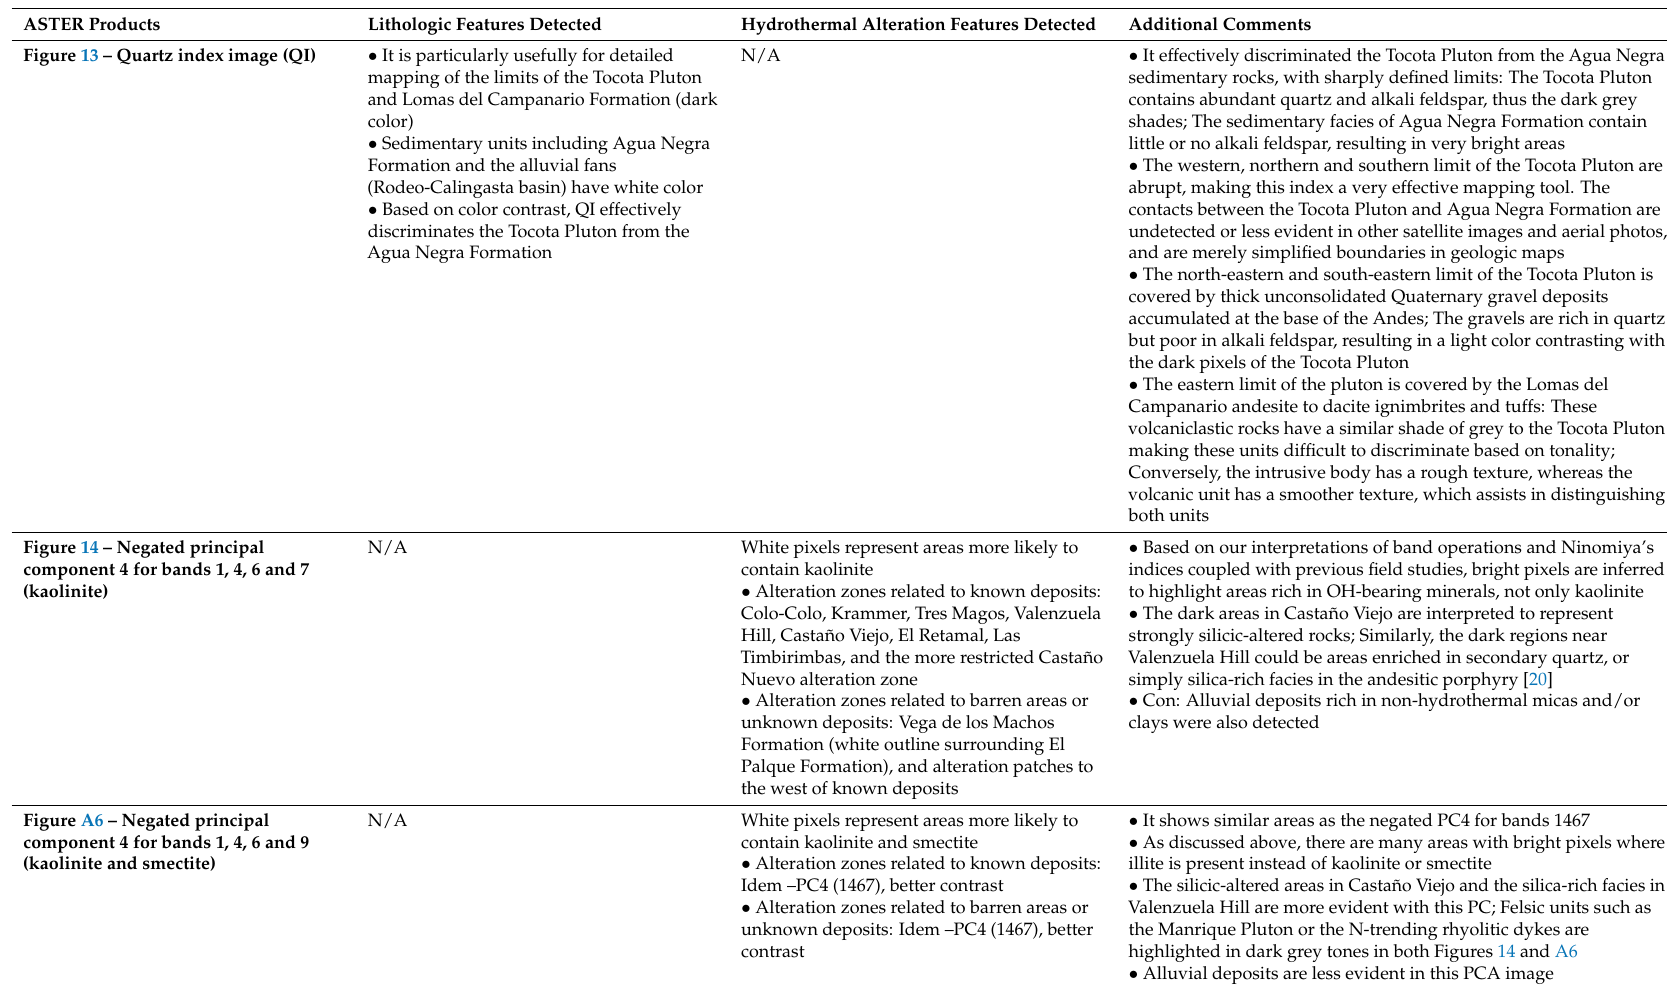
Figure A6 – Negated principal component 4 for bands 1, 4, 6 and